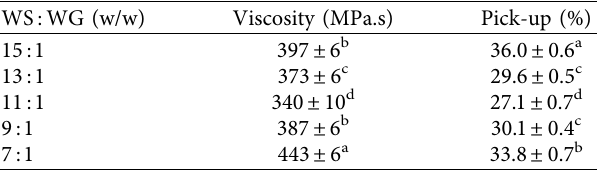
Table 2: Efect of the WS : WG ratios on the viscosity of batter and the pick-up of BBFNs (WS and WG represent wheat starch and wheat gluten, respectively; data are presented as mean value ± standard deviations from triplicate experiments ( n � 3); mean values listed in columns with diferent letters indicate statistically signifcant diferences ( p < 0 .